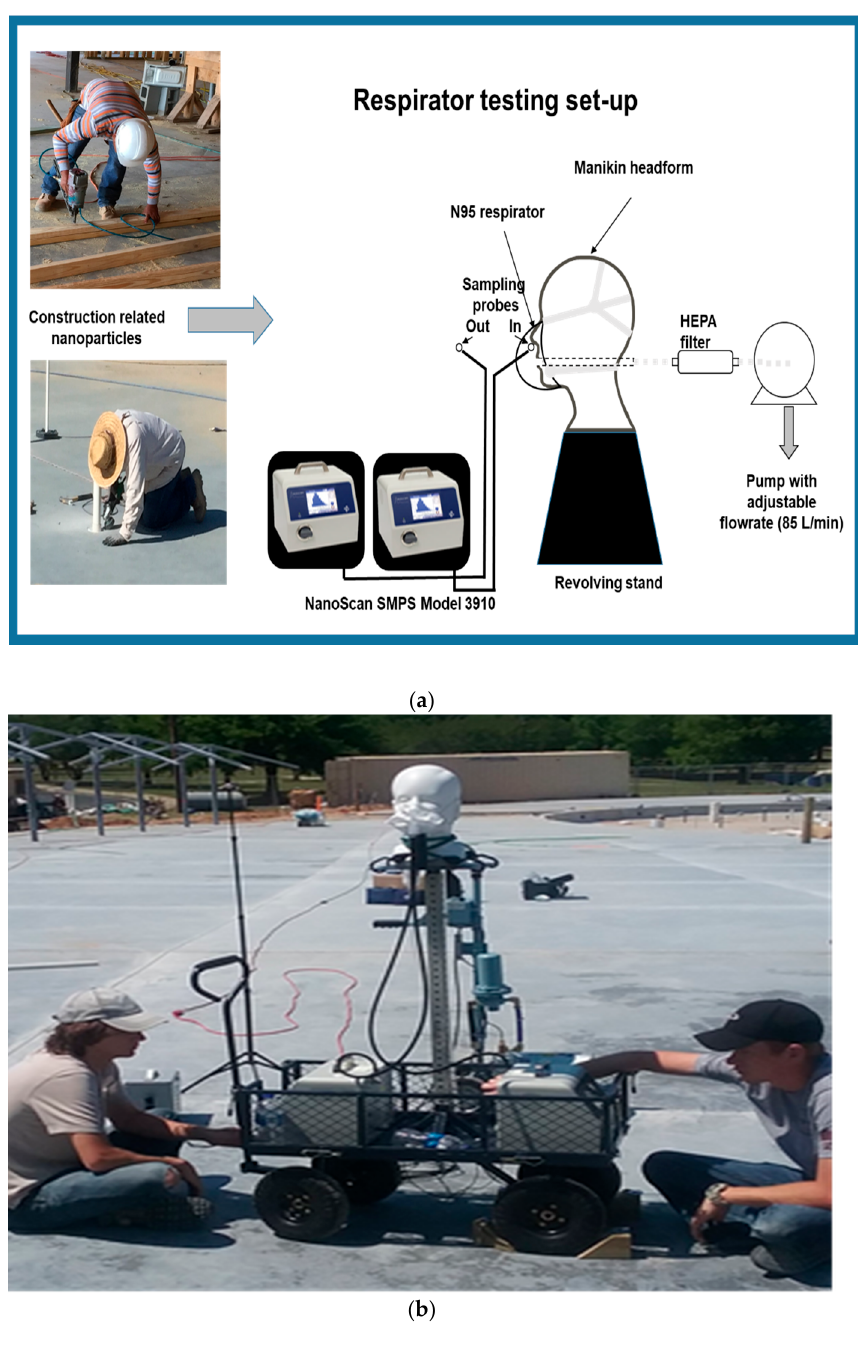
Figure 3. ( a ) Schematic of the respirator evaluation system for assessing protection offered by N95 filtering facepiece respirators in construction jobsites. ( b ) Photograph of the manikin-based N95 respirator evaluation set-up in a concrete blasting construction job site.